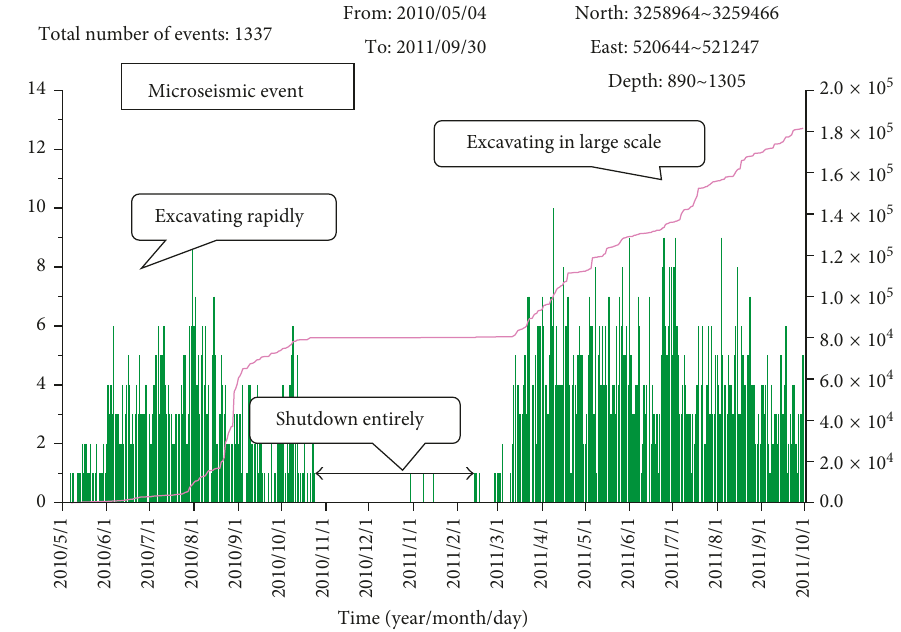
Figure 8: Correlation among the accumulative energy release, activity rate, and time of MS